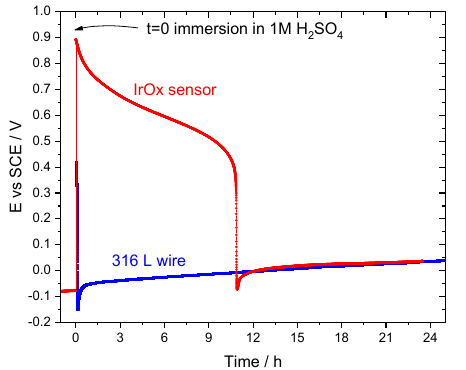
Figure 7. OCP evolution of IrOx sensor initially immersed in Ca(OH) 2 saturated solution (t < 0) and then changed to 1 M H 2 SO 4 (t > 0), compared to substrate (316L wire) response in 1 M H 2 SO 4 .